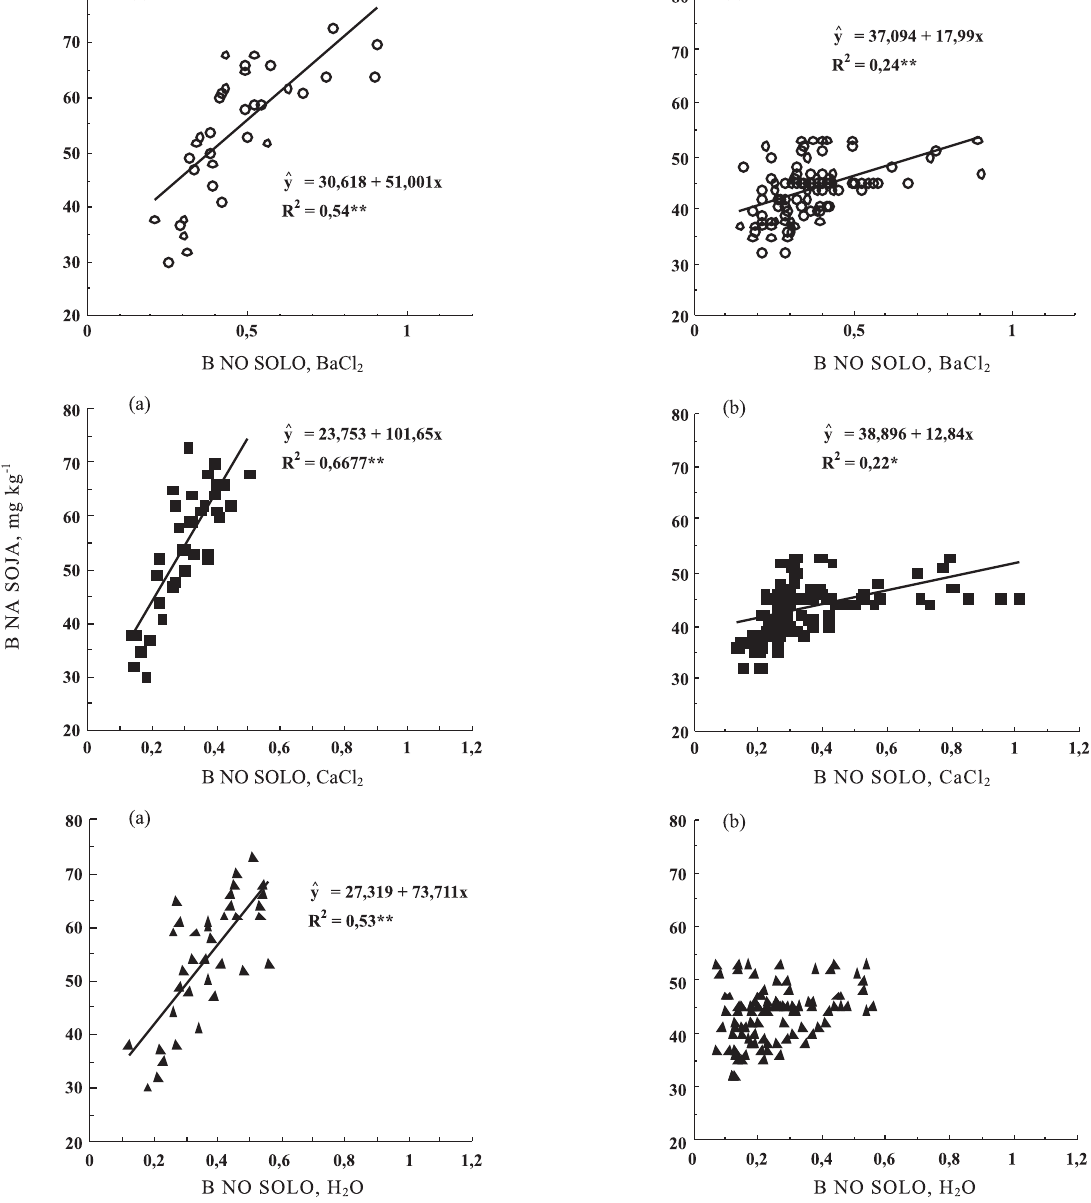
Figura 5. Teor de B em folhas de soja, em função de teores de B no solo, determinados com diversos extratores. (a) safra 2000/2001; (b) dados gerais para as três